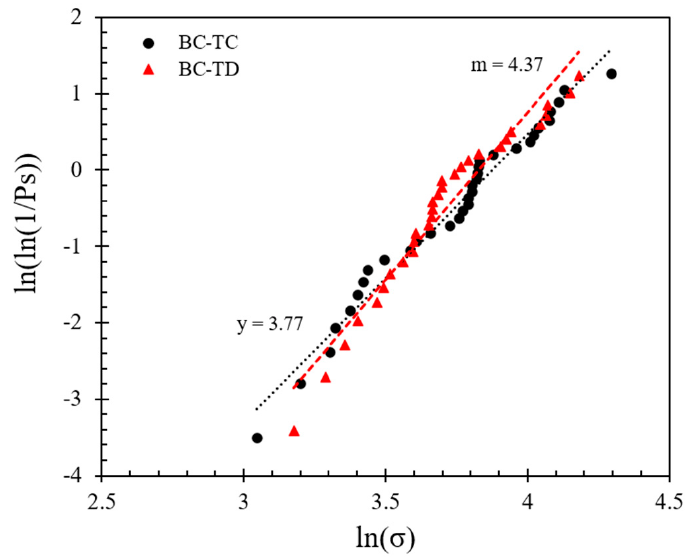
Figure 18. Comparison between different system failure modes on the Weibull distribution for loading rate 0.01 mm/min.